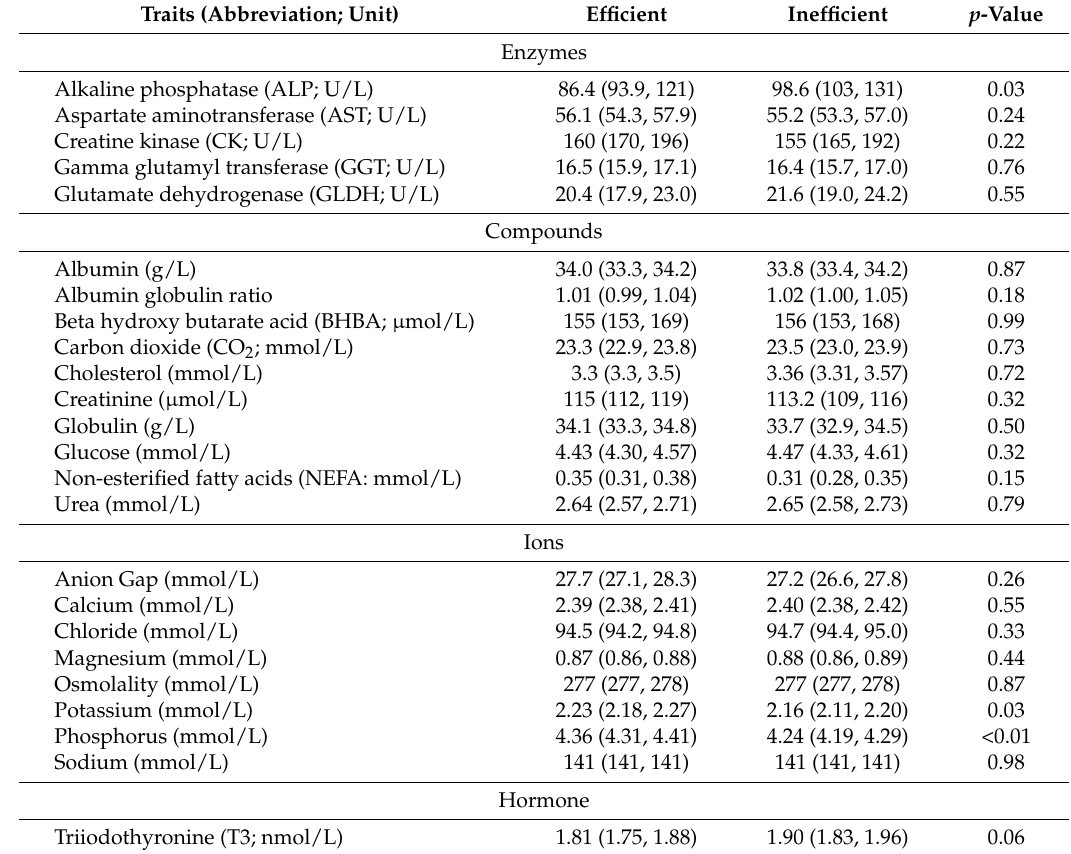
Table 4. Blood plasma analytes least square means (confidence interval) across the performance evaluation test in heifer calves by feed efficiency group repeatedly sampled.